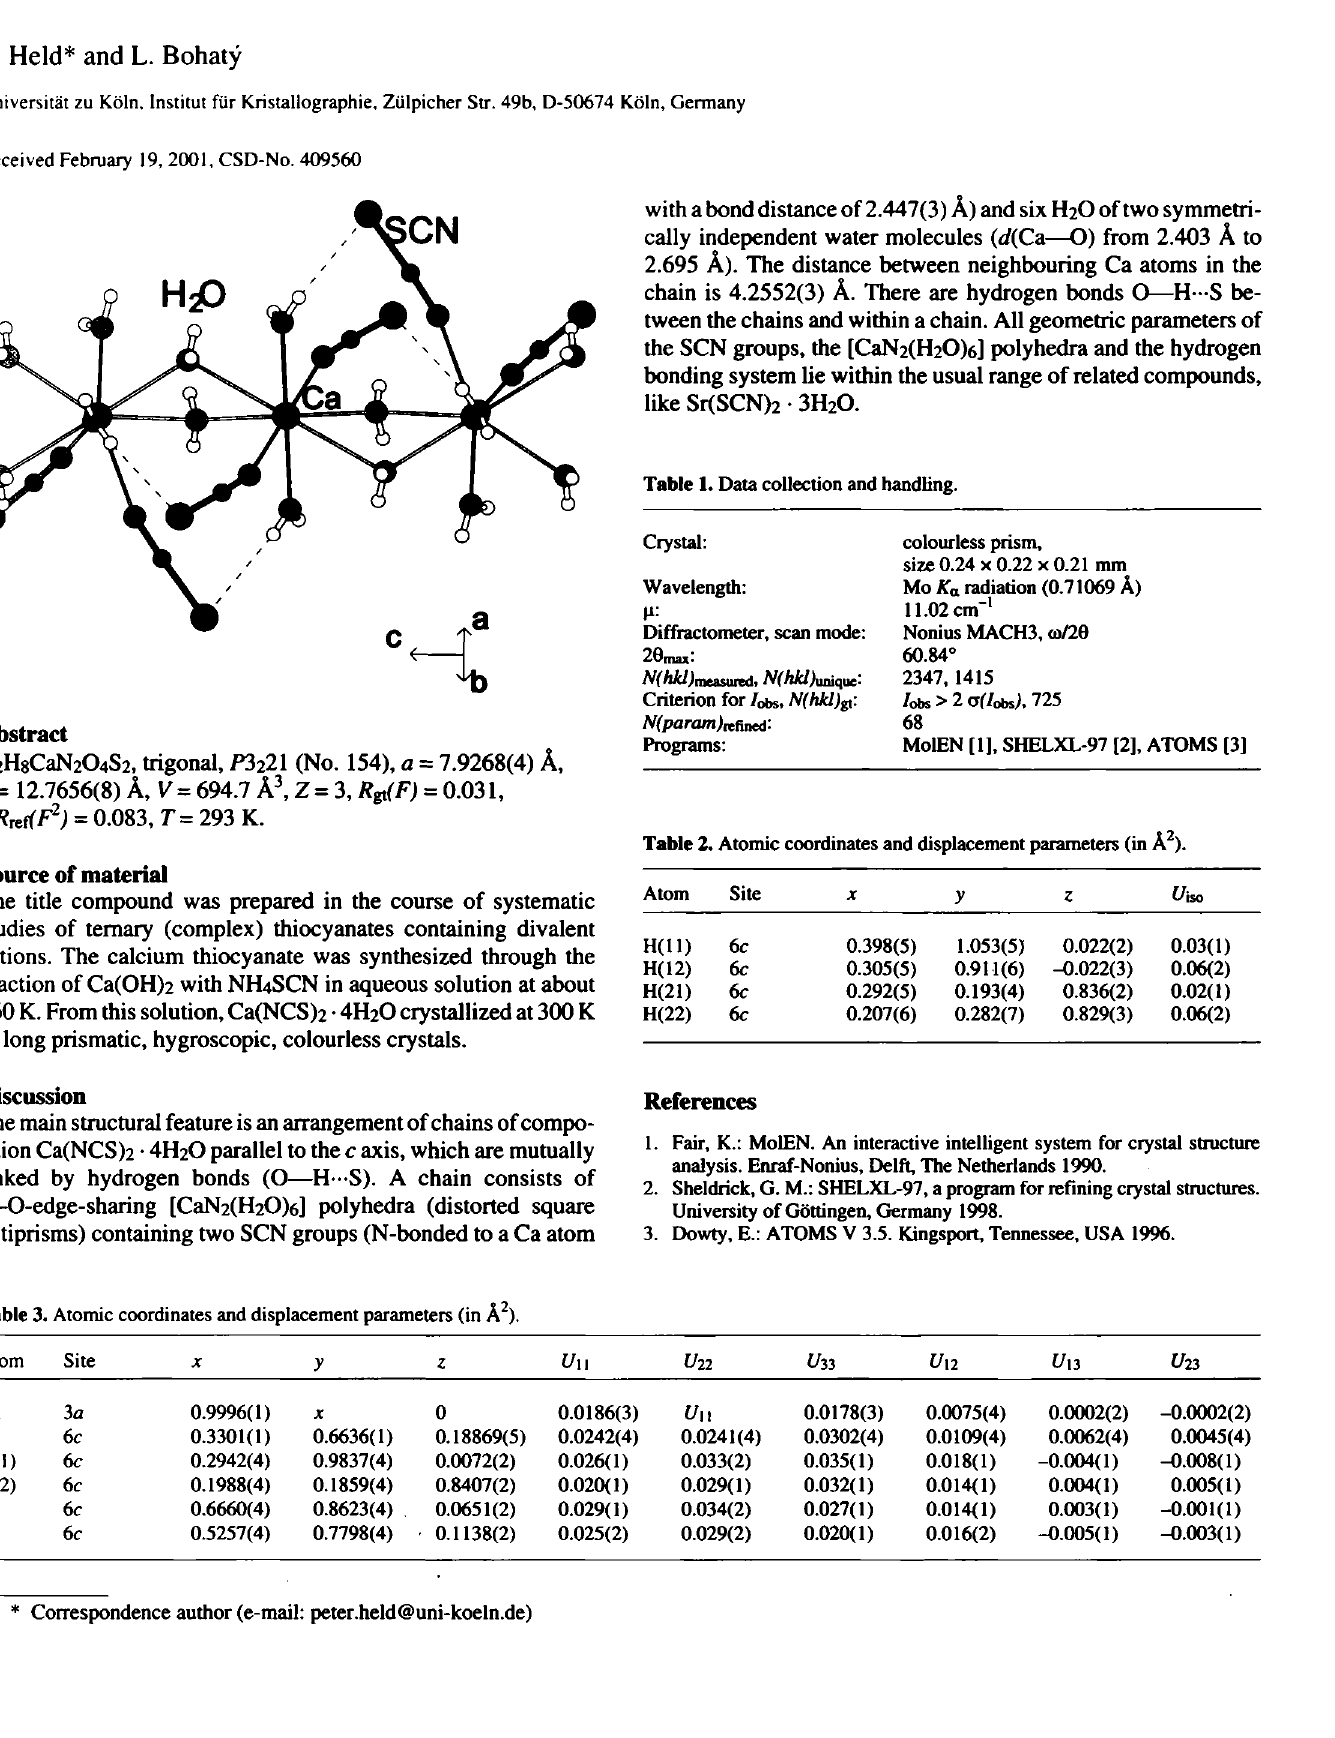
Table 1. Data collection and handling. Crystal: